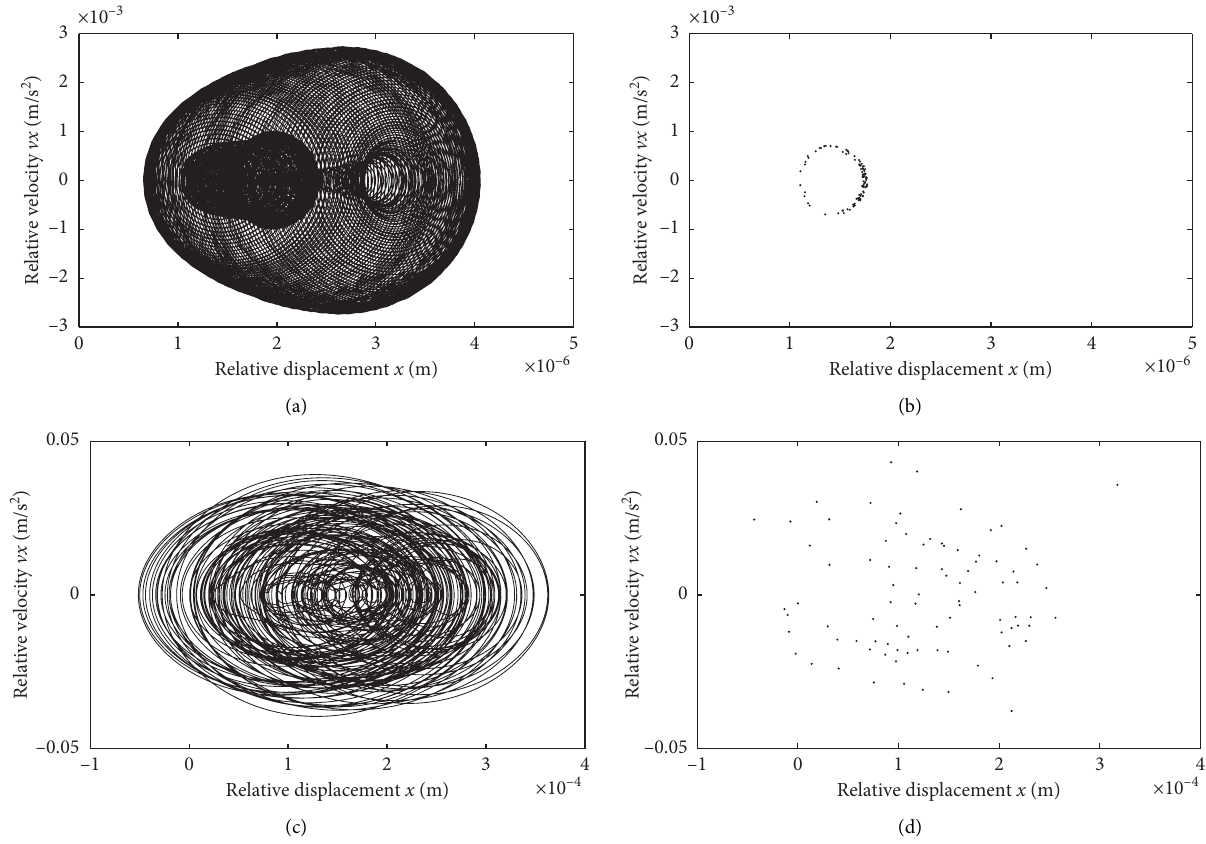
Figure 25: Phase trajectories and Poincare maps of X -direction clearances with different clearance values at clearance C. (a) Phase trace diagram at clearance C when the clearance value is 0.01mm. (b) Poincare map at clearance C when the clearance value is 0.01mm. (c) Phase trace diagram at clearance C when the clearance value is 0.8mm. (d) Poincare map at clearance C when the clearance value is 0.8mm.